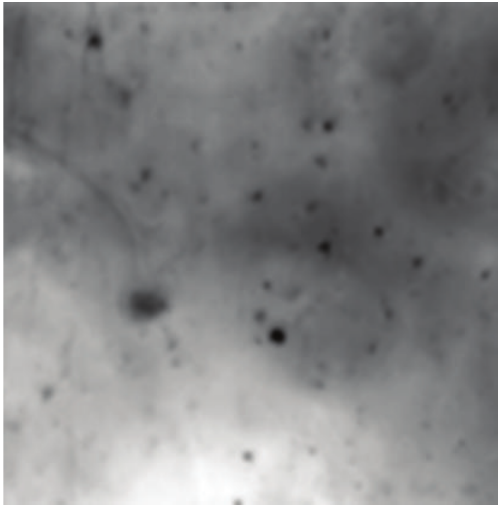
Figure 7: An example of a low contrast and blurred image on which the SVM technique did not work well; note that cell boundaries are not easily identifiable by